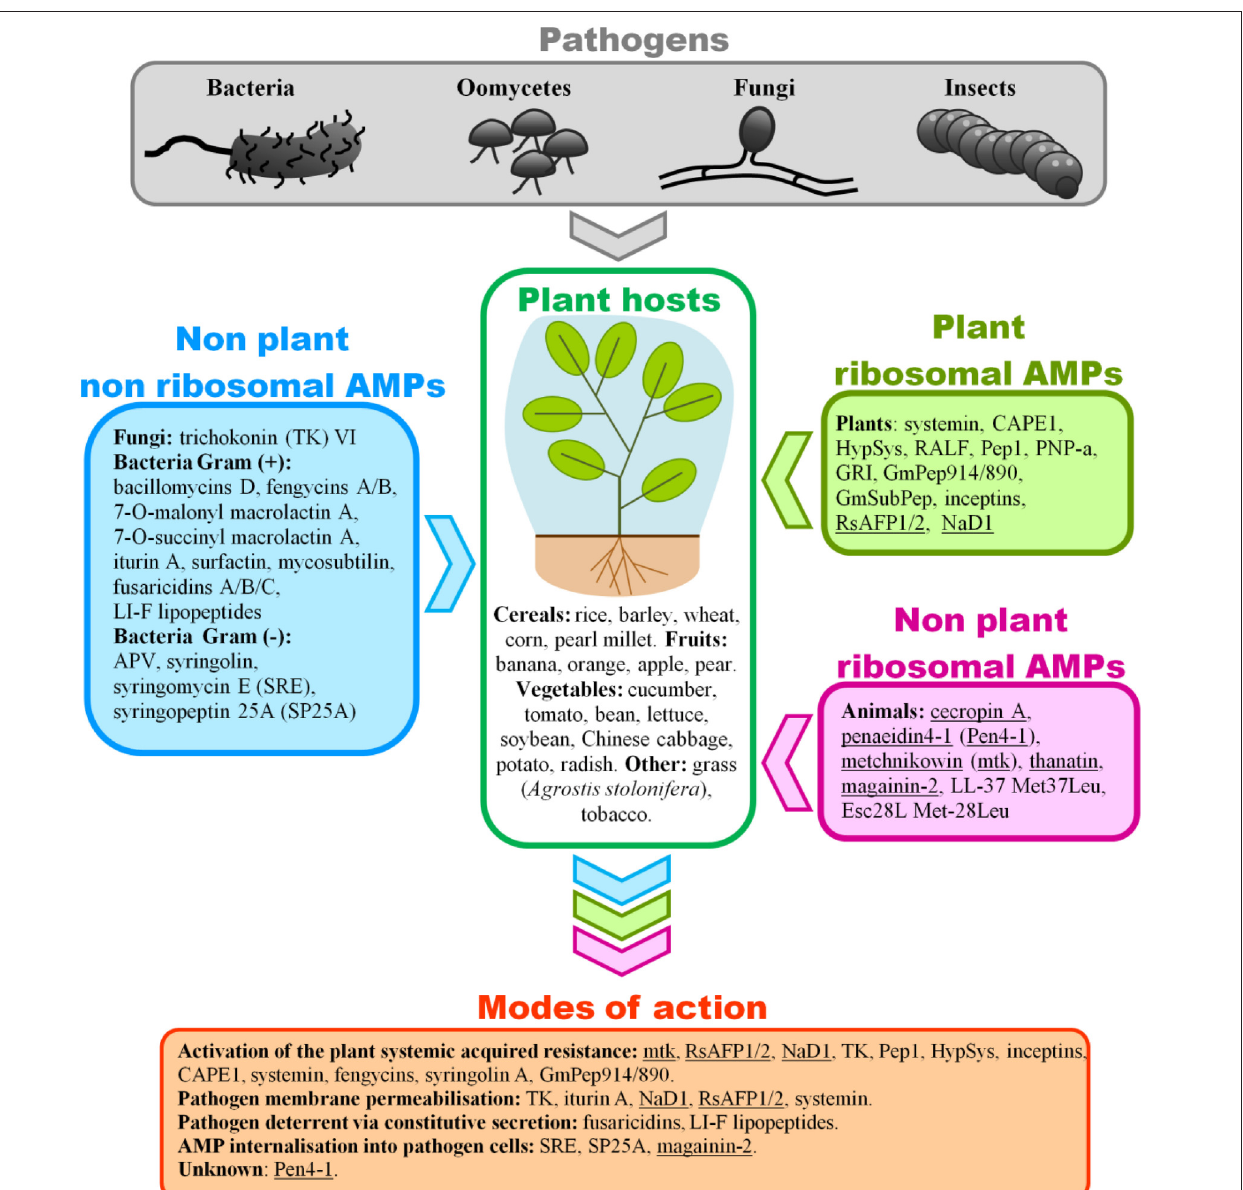
FIGURE 1 | Summary of the modes of action of non-plant and plant related AMPs involved in host resistance against plant pathogens reviewed here. A number of pests (pathogens and herbivores) can attack a crop which deploys an arsenal of defense to stay healthy. Yet some pests manage to break through plant defense mechanisms. Ribosomal and non-ribosomal AMPs synthesized by organisms other than the crop of interest offer a way to increase the plant resistance levels against pests. Their mode-of-actions, where known, mainly boosts systemic acquired resistance (SAR) of the plant host, particularly through the induction of pathogenesis-related (PR) proteins as reported for mtk, TK, CAPE1, Pep1, as well as the induction of reactive oxygen species (ROS) as reported for RsAFPs, NaD1, TK, Pep1, HypSys. Another manifestation of SAR implicates phytohormones signaling pathways as well as secondary metabolites. A number of AMPs have been associated with salicilic acid (SA) as reported for TK, inceptins, and CAPE1, jasmonic acid (JA) as reported for inceptins, CAPE1, Pep1, and systemin, and ethylene as reported for Pep1. Fengycins have been implicated in the production of phenolic compounds derived from the plant defense-related phenylpropanoid metabolism, while GmPep914/890 enhanced phytoalexin production. Syringolin A was shown to induce the transcription of Pir7b, Pir2, Pir2, and Rir1 defense genes. Another common mode of action in plant defense mechanism operates by compromising the cell membrane permeability of the pathogen. Indeed TK was involved in the change of fungal membrane permeability and disintegration of subcellular structures, while iturin A was associated with the creation of transmembrane channels thus resulting in the release of vital ions such as K+. NaD1, interacting with PIP2, triggered the granulation of the hyphal cytoplasm followed by cell death. The interaction of RsAFP1/2 with fungal membrane glucosylceramide (GlcCer) resulted in the activation of MAP kinase and cell wall integrity signaling pathways. Systemin caused a rapid alkalinization of the extracellular space via blockage of a proton pump in the cell membrane. AMP internalization into pathogen cells can be mediated by cell wall degrading enzymes (CWDEs) as reported for syringomycin E (SRE), syringopeptin 25A (SP25A), and magainin-2. Finally some AMPs act as pathogen deterrent via (Continued)